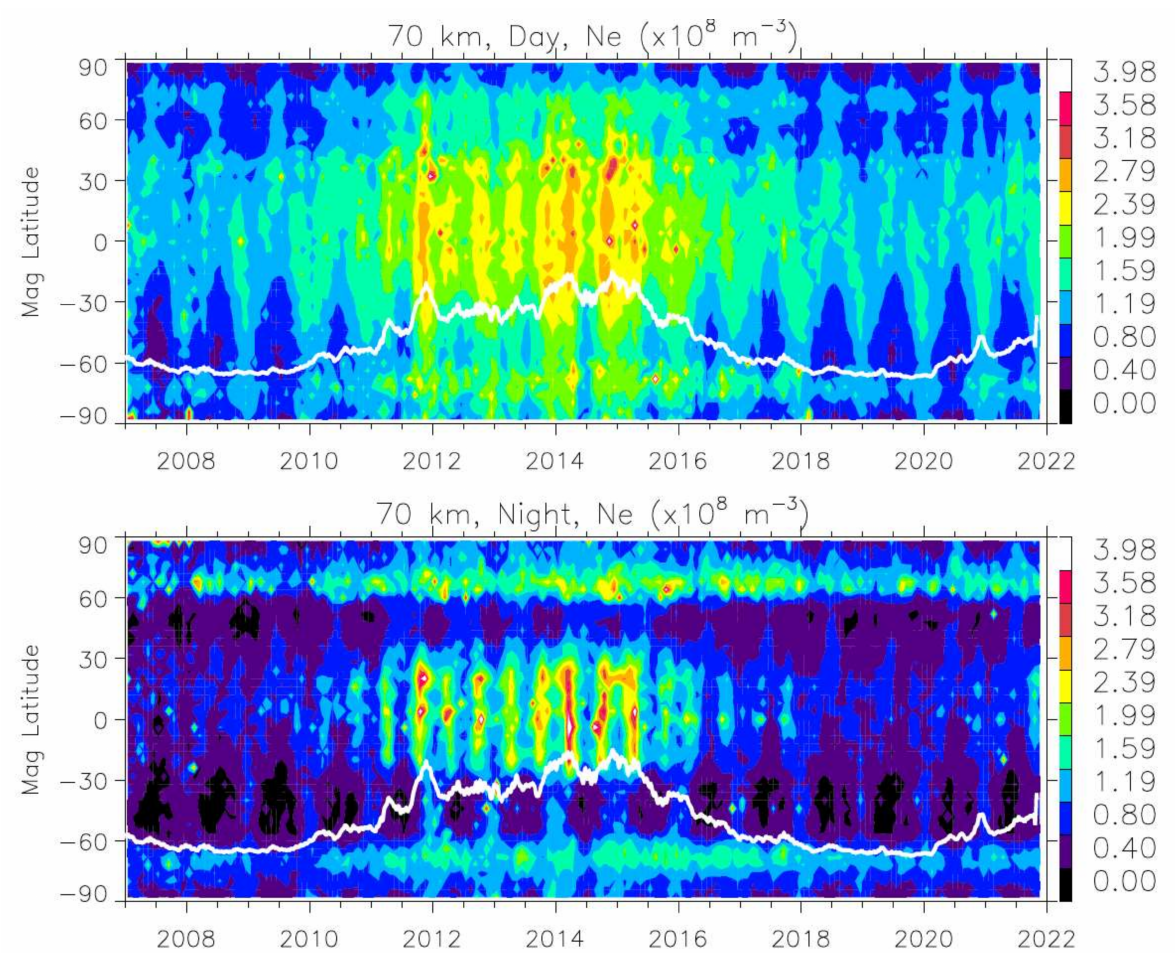
Figure 13. Solar cycle variations of daytime ( top ) and nighttime ( bottom ) N e at 70 km as a function of magnetic latitude from the combined MetOp-A/B/C and SAC-C (before 2008) monthly averages. The longterm variations at other altitudes (60 and 80 km) can be found in Figure S5. The time series of daily Ly- α is the overplotted white line. The Ly- α data are obtained from the GSFC’s Space Physics Data Facility (SPDF) OMNIweb